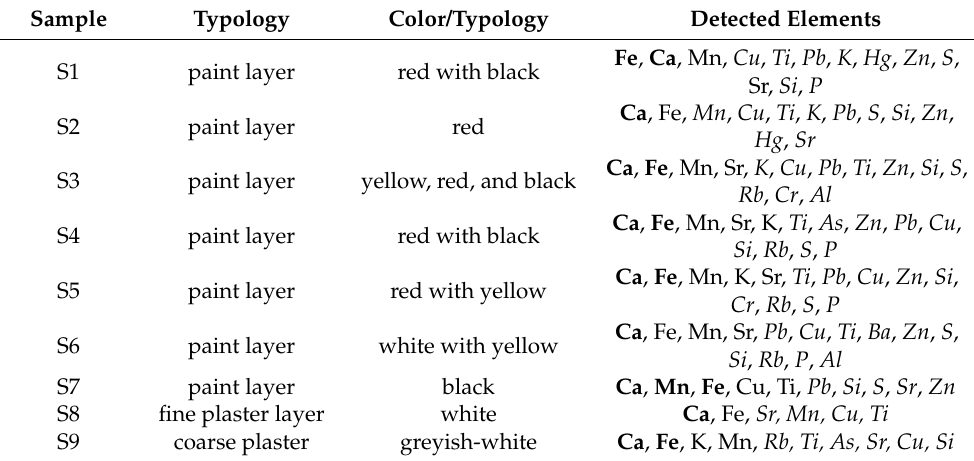
Table 1. Results of the XRF analysis. Identified elements are shown in order of decreasing abundance (major abundant elements are marked in bold; trace elements are marked in